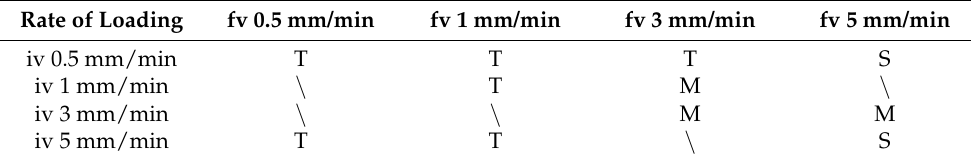
Table 5. Statistical table of 30–90 failure modes of